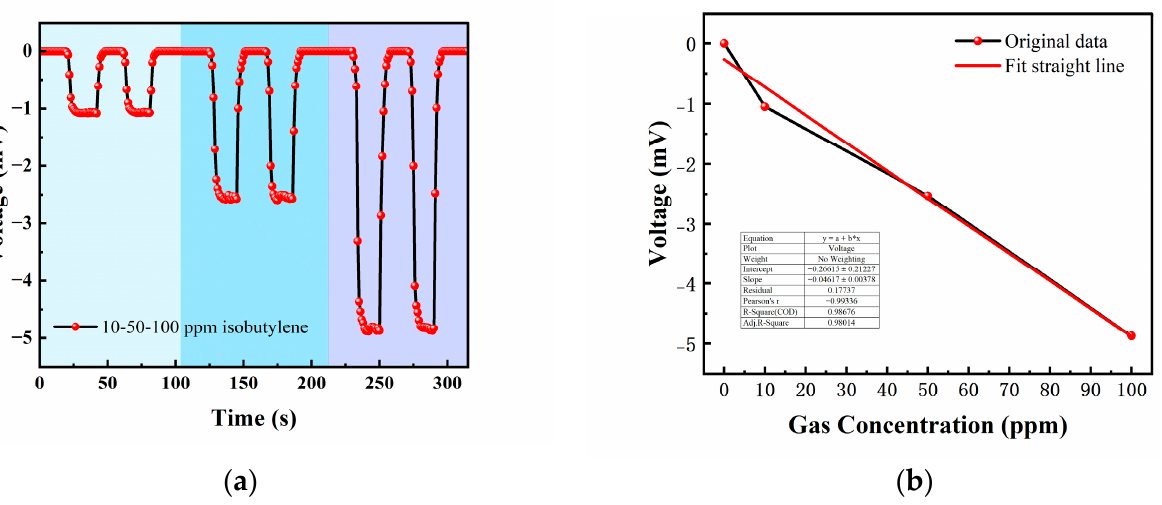
Figure 12. ( a ) 10, 50, 100 ppm isobutylene gas concentration test; ( b ) isobutylene gas concentration– voltage; fitting a straight line.